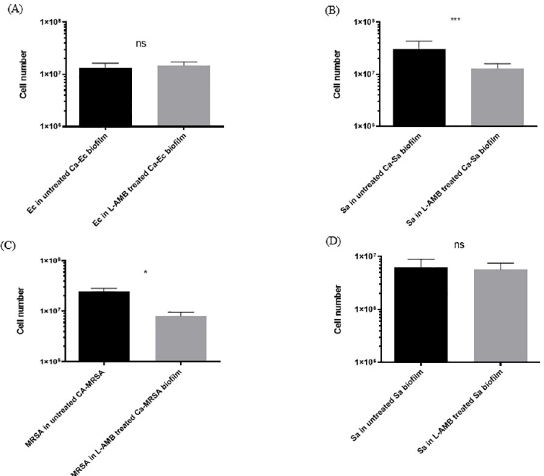
Fig 3. PMA-qPCR quantification of E . coli , S . aureus and MRSA in liposomal amphotericin (AmBisome 1 ) treated dual-species and axenic S . aureus biofilms. (A) Cell numbers of E . coli (Ec) and (B) S . aureus (Sa) in untreated and liposomal amphotericin (L-AMB) treated dual-species biofilms grown with C . albicans laboratory strain (NCTC 3179). (C) Cell numbers of MRSA (clinical isolate) in untreated and liposomal amphotericin (L-AMB) treated dual-species biofilms grown with C . albicans clinical isolate. (D) Cell numbers of S . aureus (Sa) in untreated and L-AMB treated axenic biofilms. (Mann-Whitney statistical analysis, 3 independent experiments ns: p > 0.05; � : p < 0.05, ��� : p < 0.001, error bars